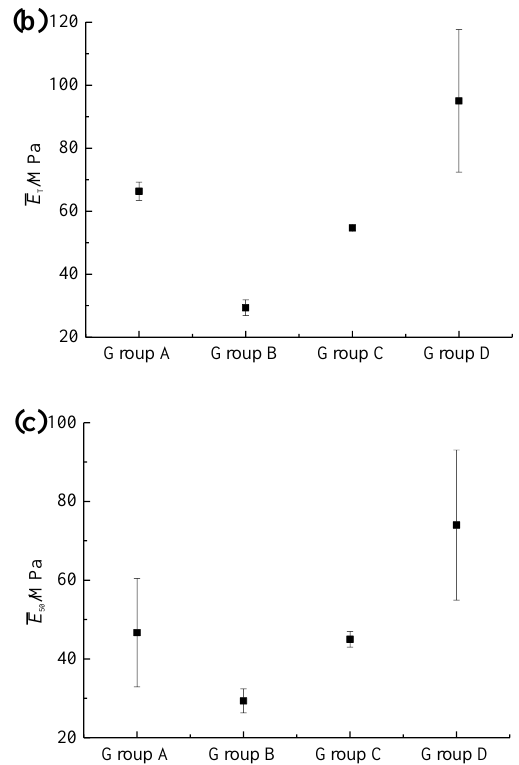
Figure 4. Variation of the uniaxial compression test result error bars with the coal particle size. ( a ) The relationship between uniaxial compressive strength and coal particle size; ( b ) the relationship between elastic modulus and coal particle size; and ( c ) the relationship between deformation modulus and coal particle size.